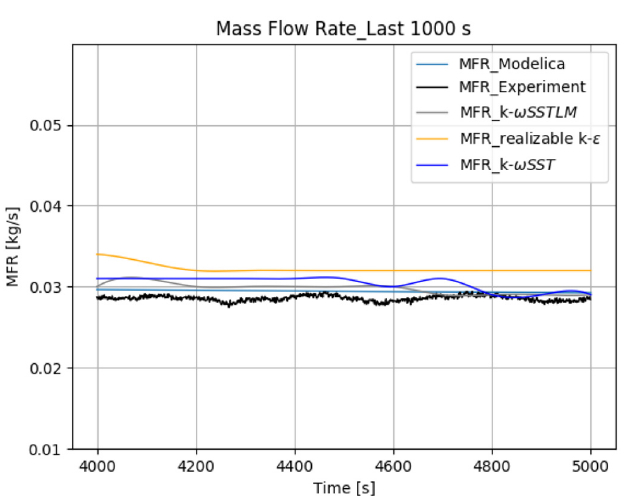
Fig. 10. Temperature difference across the cooler.